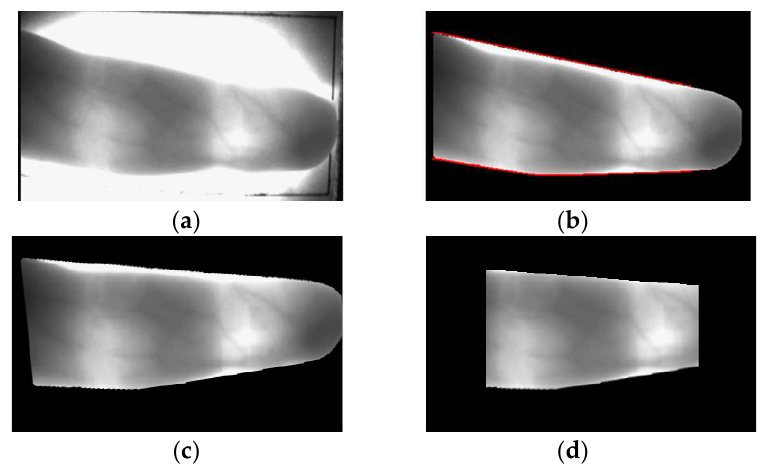
Figure 3. Examples of in-plane rotation compensation: ( a ) original input image; ( b ) extracted finger region by step 2 of Figure 1; ( c ) image by in-plane rotation compensation; and, ( d ) detected finger region-of-interest (ROI).